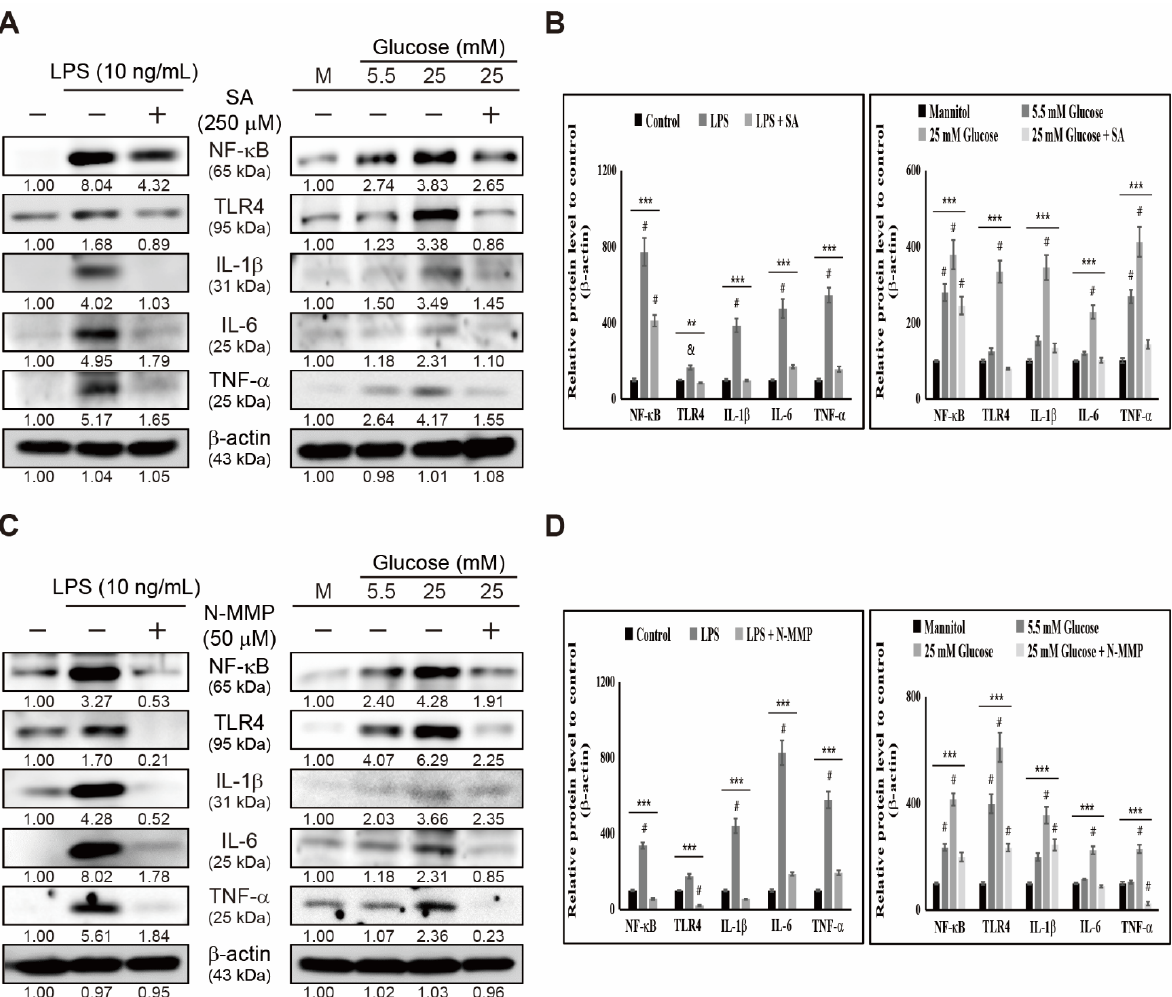
Figure 4. Inhibiting heme synthesis suppresses inflammatory responses. ( A ) Western blotting of TLR4, NF ‐κ B, IL ‐ 6, IL ‐ 1 β , and TNF ‐α proteins in THP ‐ 1 cells after treatment with SA (250 μ M), LPS (10 ng/mL) for 48 h, and mannitol or glucose (5.5 and 25 mM) for 72 h. Expression levels were estimated by densitometry and normalized to β‐ actin. Data are representative of three independent experiments. ( B ) Graphical representation of TLR4, NF ‐κ B, IL ‐ 6, IL ‐ 1 β , and TNF ‐α proteins in THP ‐ 1 cells after treatment with SA (250 μ M) and LPS (10 ng/mL) for 48 h. ** p < 0.01. & p < 0.01 vs. control. *** p < 0.001 (ANOVA test). # p < 0.001 vs. control. Graphical representation of TLR4, NF ‐κ B, IL ‐ 6, IL ‐ 1 β , and TNF ‐α proteins in THP ‐ 1 cells after treatment with SA (250 μ M) and mannitol or glucose (5.5 and 25 mM) for 72 h. Data were repeated thrice for confirmation. *** p < 0.001 (ANOVA test). # p < 0.001 vs. control. ( C ) Western blotting of TLR4, NF ‐κ B, IL ‐ 6, IL ‐ 1 β , and TNF ‐α proteins in THP ‐ 1 cells after treatment with N ‐ MMP (50 μ M), LPS (10 ng/mL) for 48 h, and mannitol or glucose (5.5 and 25 mM) for 72 h. Expression levels were estimated by densitometry and normalized to β‐ actin. Data were repeated thrice for confirmation. ( D ) Graphical representation of TLR4, NF ‐κ B, IL ‐ 6, IL ‐ 1 β , and TNF ‐α proteins in THP ‐ 1 cells after treatment with N ‐ MMP (50 μ M) and LPS (10 ng/mL) for 48 h. *** p < 0.001 (ANOVA test). # p < 0.001 vs. control. Graphical representation of TLR4, NF ‐κ B, IL ‐ 6, IL ‐ 1 β , and TNF ‐α proteins in THP ‐ 1 cells after treatment with N ‐ MMP (50 μ M) and mannitol or glucose (5.5 and 25 mM) for 72 h. *** p < 0.001 (ANOVA test). # p < 0.001 vs. control.